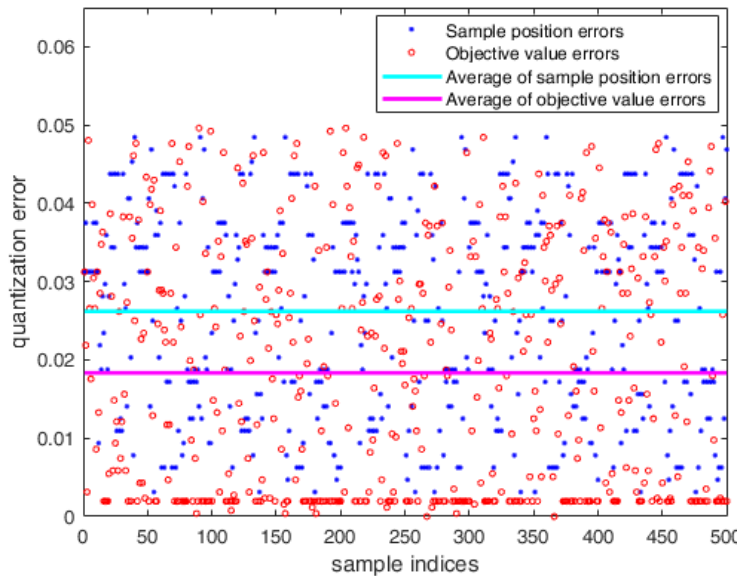
Figure 13. The quantization errors for sample positions and objective values between the conventional MCO and the FRMCO with 500 samples.